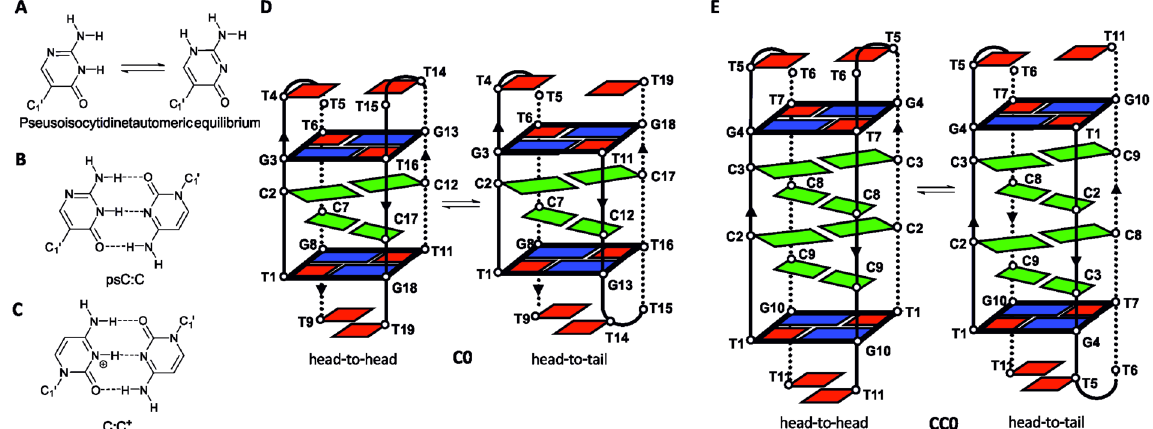
Figure 1. Expected base-pairs in psC-containing i-motifs and schematic representations of the structural equilibrium in C0 and CC0 . ( A ) Tautomeric equilibrium of pseudoisocytidine. ( B ) Neutral psC:C base pair. ( C ) Hemiprotonated C:C + base pair in i-motif structures. ( D , E ) Head-to-head and head-to-tail dimeric i-motif structures of C0 and CC0 , respectively.